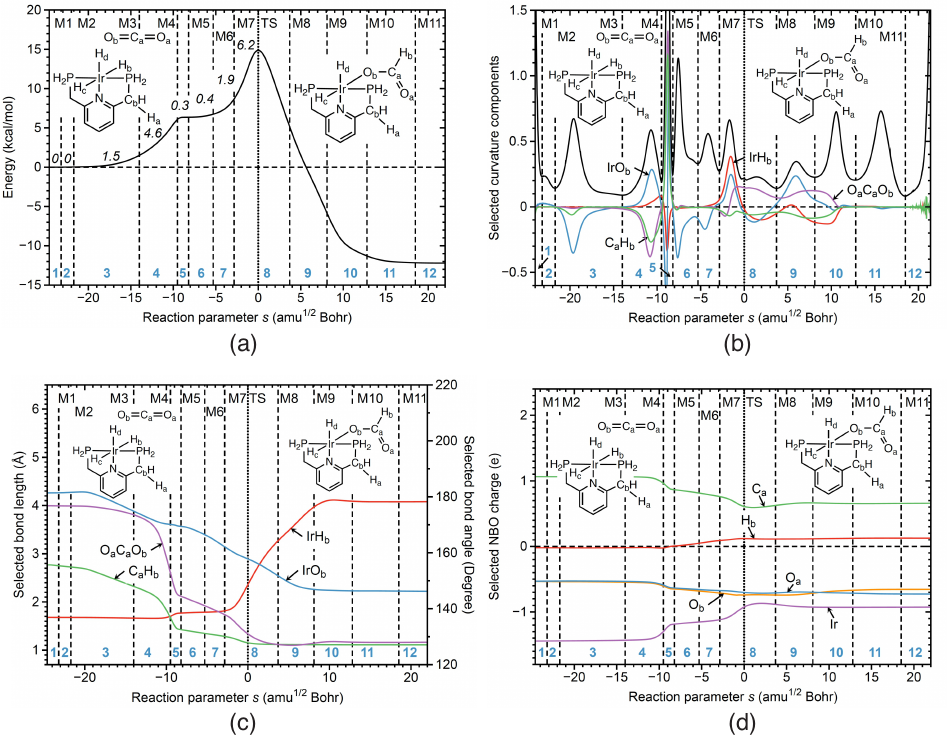
Figure 5. Properties of reaction R1 of the catalytic cycle along the reaction path. ( a ) Energy profile, energy contributions of each reaction phase to the activation energy are indicated by italic numbers; ( b ) decomposition of the reaction curvature into selected components; ( c ) change of selected bond lengths along s ; ( d ) change of selected NBO atomic charges along s . Positions of the curvature minima are shown as dashed vertical lines and are labeled as M1, M2, and so on. The position of the TS is indicated by a dotted line. Reaction phases are indicated by blue numbers. B3LYP/6- 31G(d,p)/SDD(Ir) level of